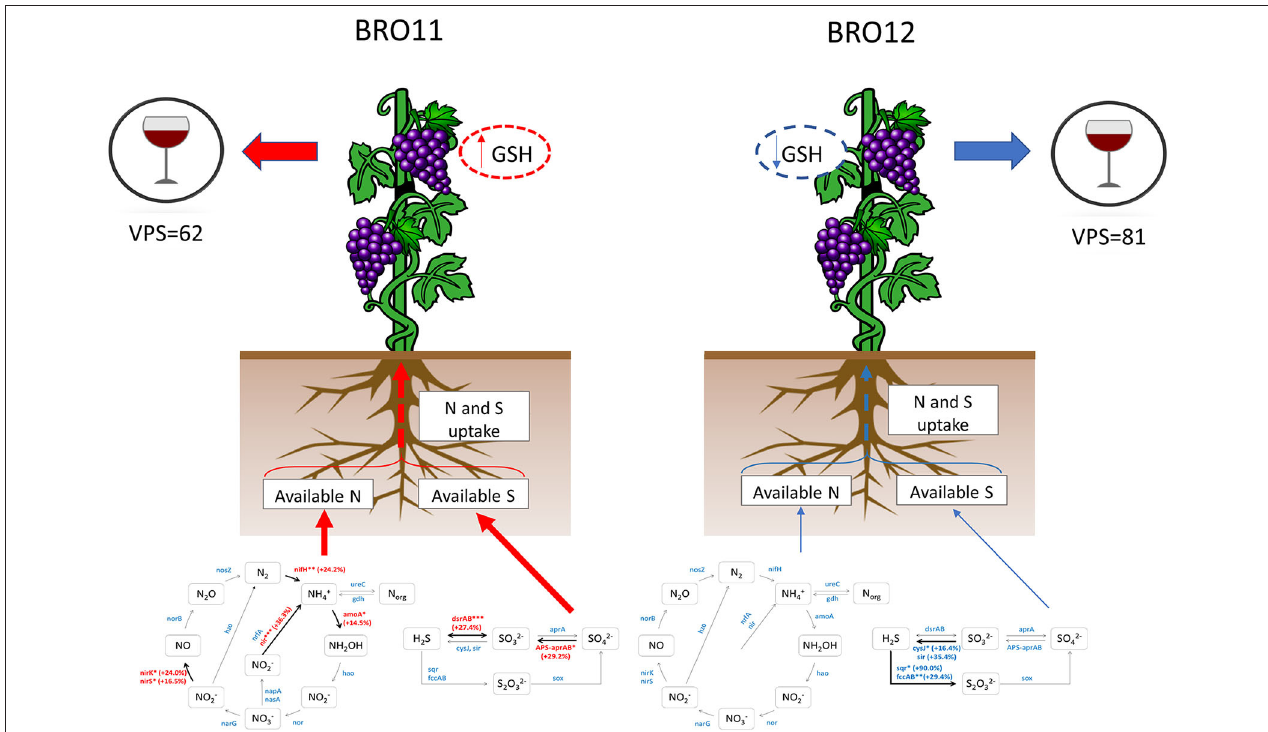
FIGURE 7 | Schematic overview of the potential effects of the different nitrogen and sulfur availability on the plant physiology and wine quality of BRO11 and BRO12 plots. On BRO11 the higher availability of sulfate and nitrogen is supposed to enhance the plant uptake of such nutrients, thus promoting the synthesis of reduced glutathione (GSH) and reducing the phenolic compounds which determine the final wine quality (VPS). Dashed lines indicate the hypothetic effect whereas the reduced arrow’s thickness in BRO12 indicates a minor amount of available nitrogen ad sulfate.